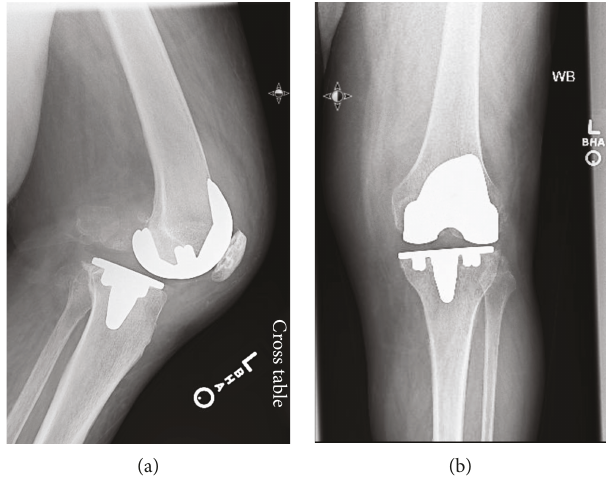
Figure 1: (a, b) AP and lateral views of the knee 6 weeks post-op. Normal knee architecture in both views.